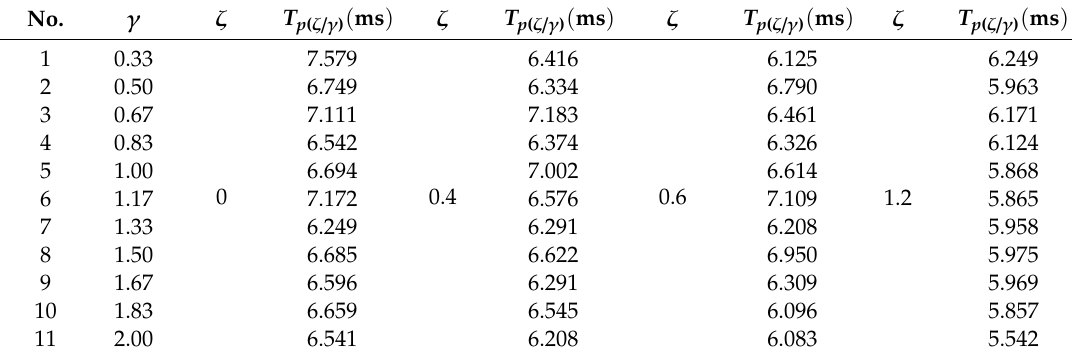
Table A3. The existence time of the first bubble